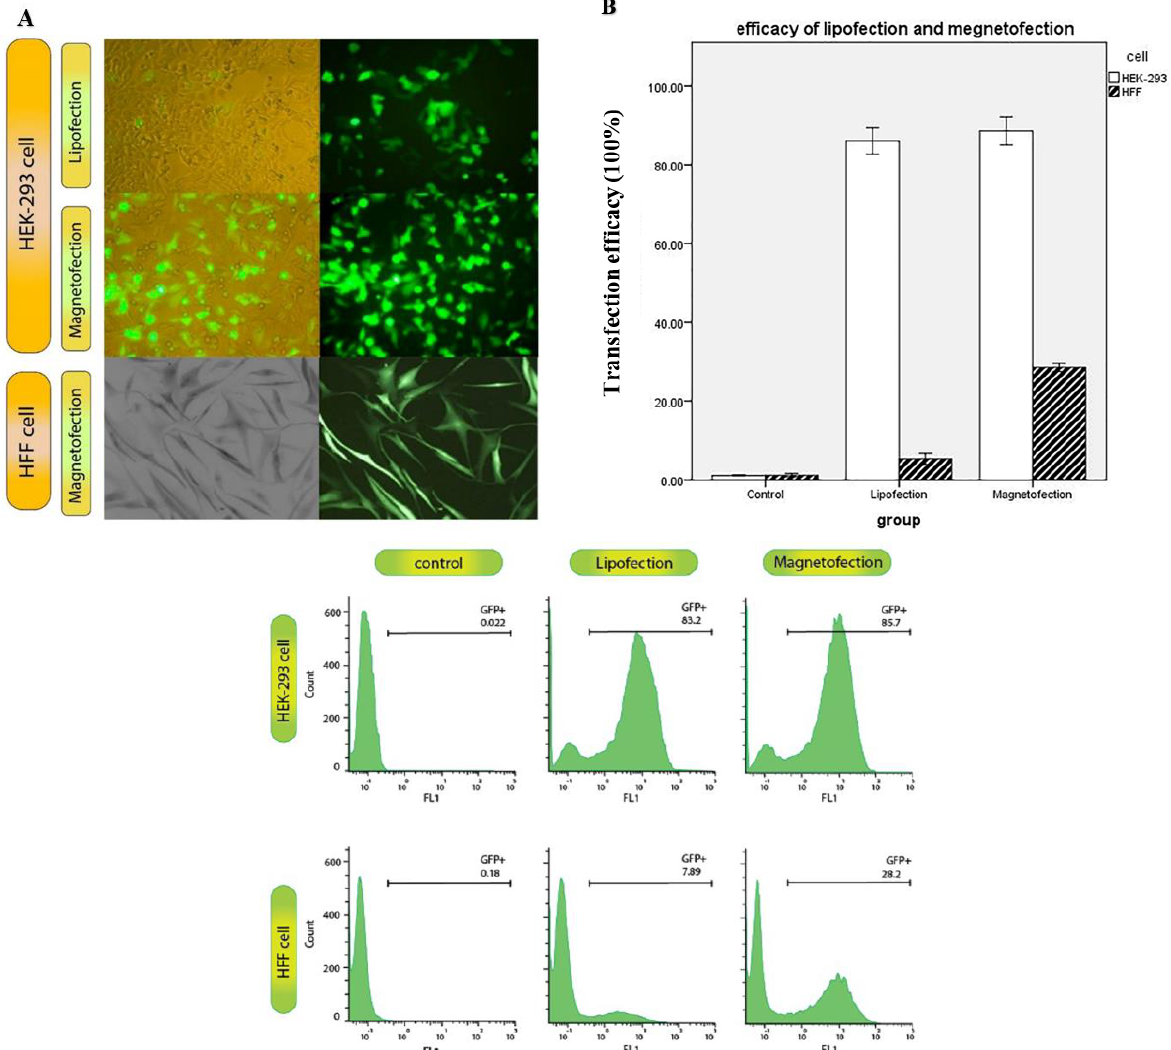
Figure 5. ( A ) Quantification of the transfection efficacy of the CRISPR/Cas9-PEI-MNP complex in the HEK-293 and HFF cells using two reagents. ( B ) Fluorescent microscopy image of the HEK293 and HFF cells transfected using the CRISPR/Cas9-PEI-MNP complex (×40 magnification for HEK-293 and ×100 magnification for HFF cell). ( C ) Flow cytometry representative data of the HEK-293 and HFF cells transfected using the CRISPR/Cas9-PEI-MNP complex.